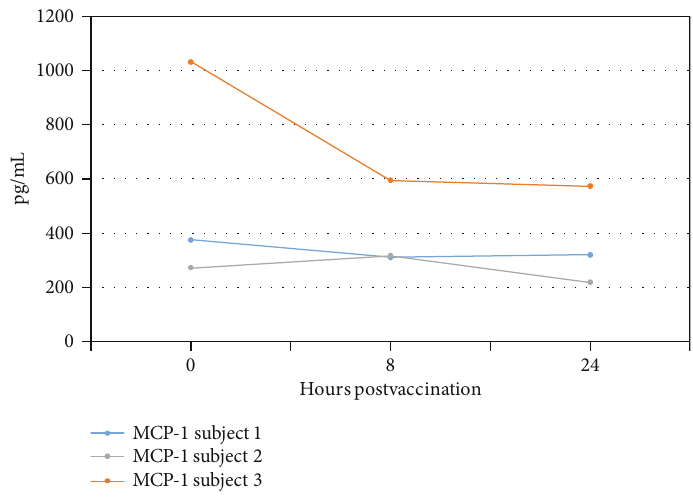
Figure 4: MCP-1 response